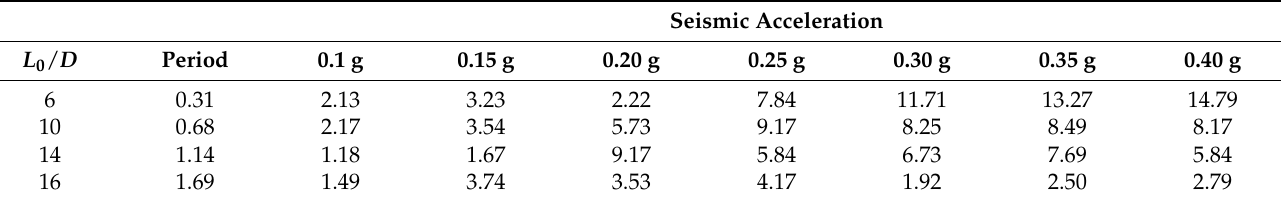
Table 5. The columns damage growth rate (%).